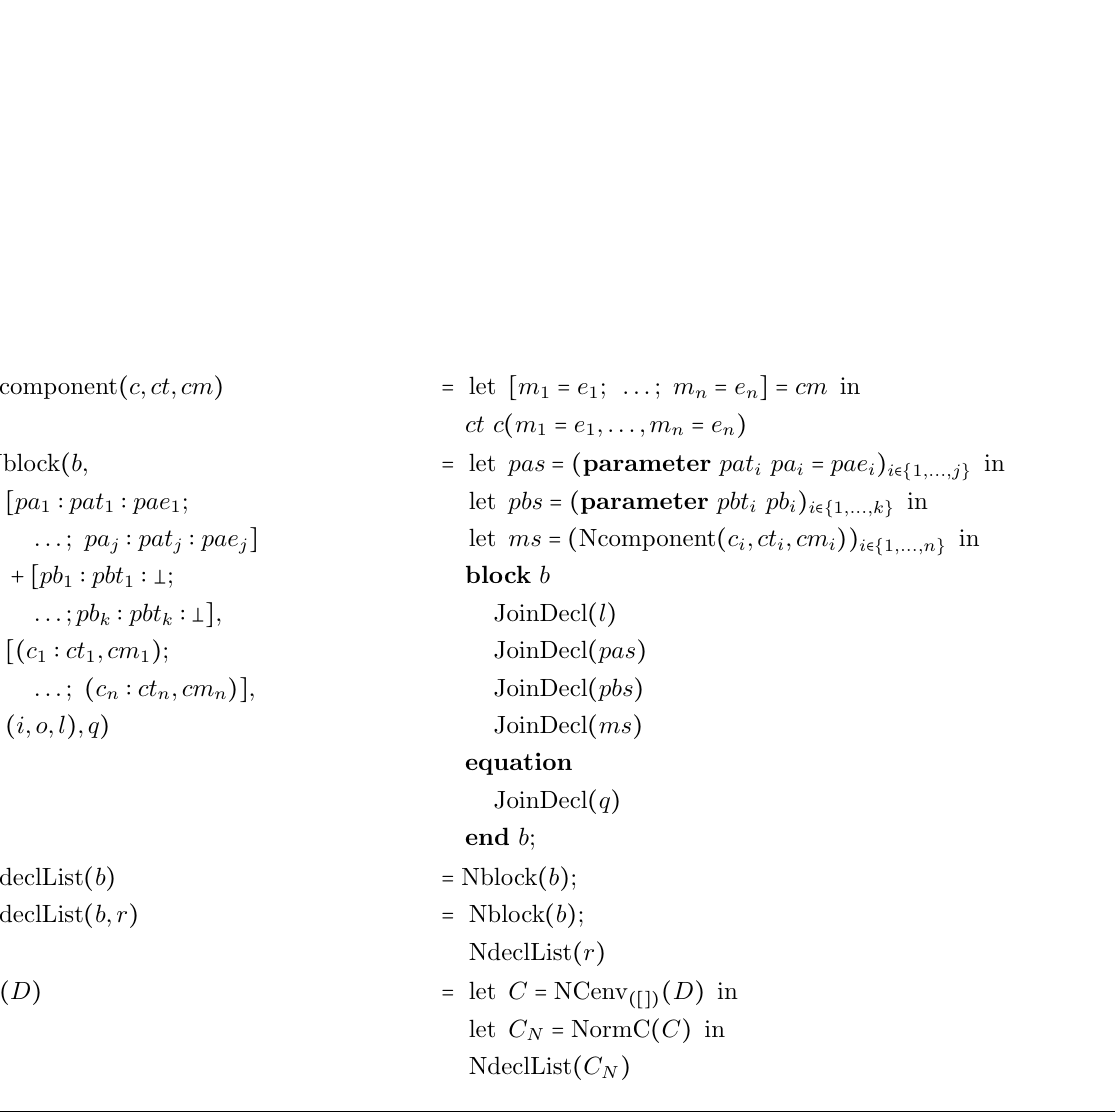
Figure 17: Translation from the mACG-Modelica language into the normalized mACD-Modelica language. The translation function N ( D ) utilizes functions NCenv (Figure 18) and NormC (Figure 19) for the transformation and the remaining functions for transforming the auxiliary representation structure C N to normalized